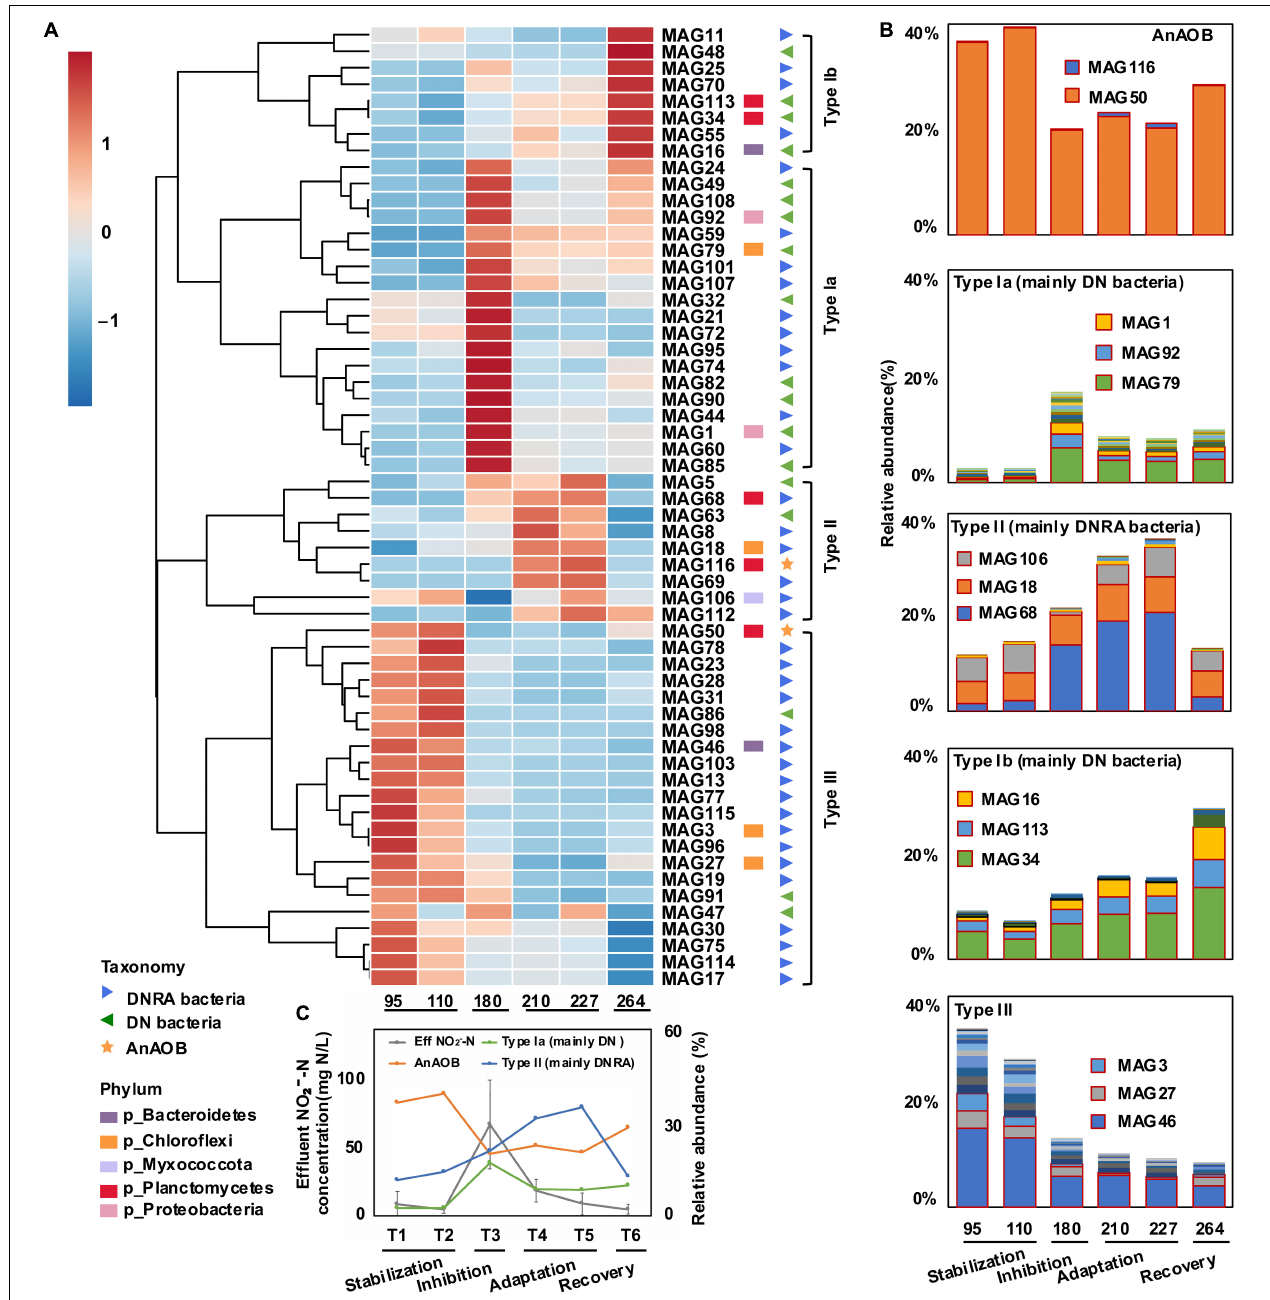
FIGURE 4 | Analysis of bioreactor’s community clustering based on relative abundance of MAGs. A clustering heatmap of anammox (AnAOB), denitrifying (DN) bacteria, and dissimilatory nitrate reduction to ammonium (DNRA)-related metagenome-assembled genomes (MAGs) among experimental phases was generated at six time points (A) . Rows were first normalized, and heatmap was created based on a Euclidean distance matrix and clustered with complete method. Color scale was marked with high positive correlation in red and negative correlation in blue. Relative abundance of AnAOB and type Ia, Ib, II, and III bacteria were shown in (B) . MAGs with high relative abundance were marked in red boxes. Relative abundance of AnAOB, type Ib and type II bacteria at six time points (day 95, day 110, day 180, day 210, day 227, and day 264) as well as average effluent NO 2 − -N around sample collection time (T1: days 51–95, T2: days 96–110, T3: days 150–180, T4: days 188–210, T5: days 211–227, and T6: day 228–264) were shown in (C)